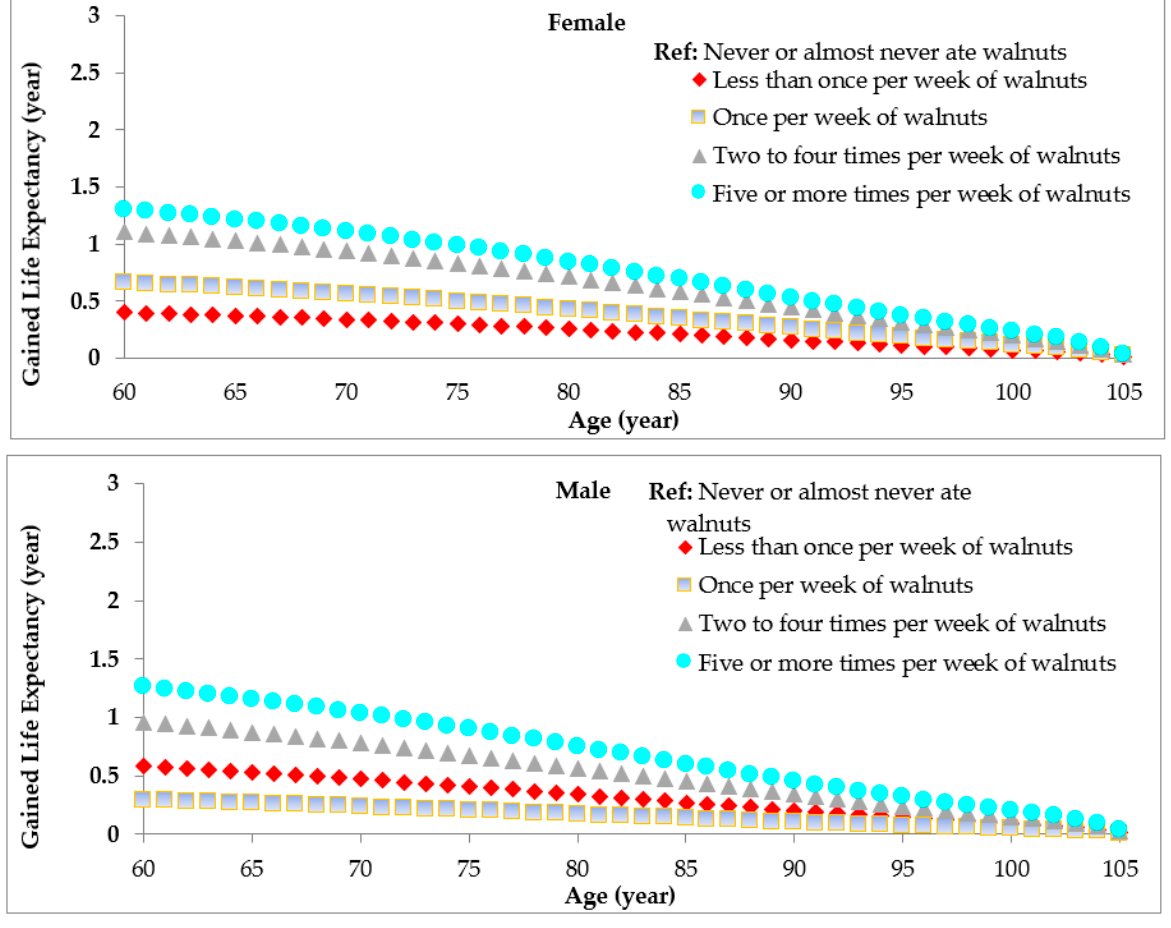
Figure 2. Estimated life expectancy by age and sex according to the frequency of walnut consumption. Overall life expectancy is projected from the overall mortality rate of Americans from Centers of Disease Control and Prevention (CDC) Report